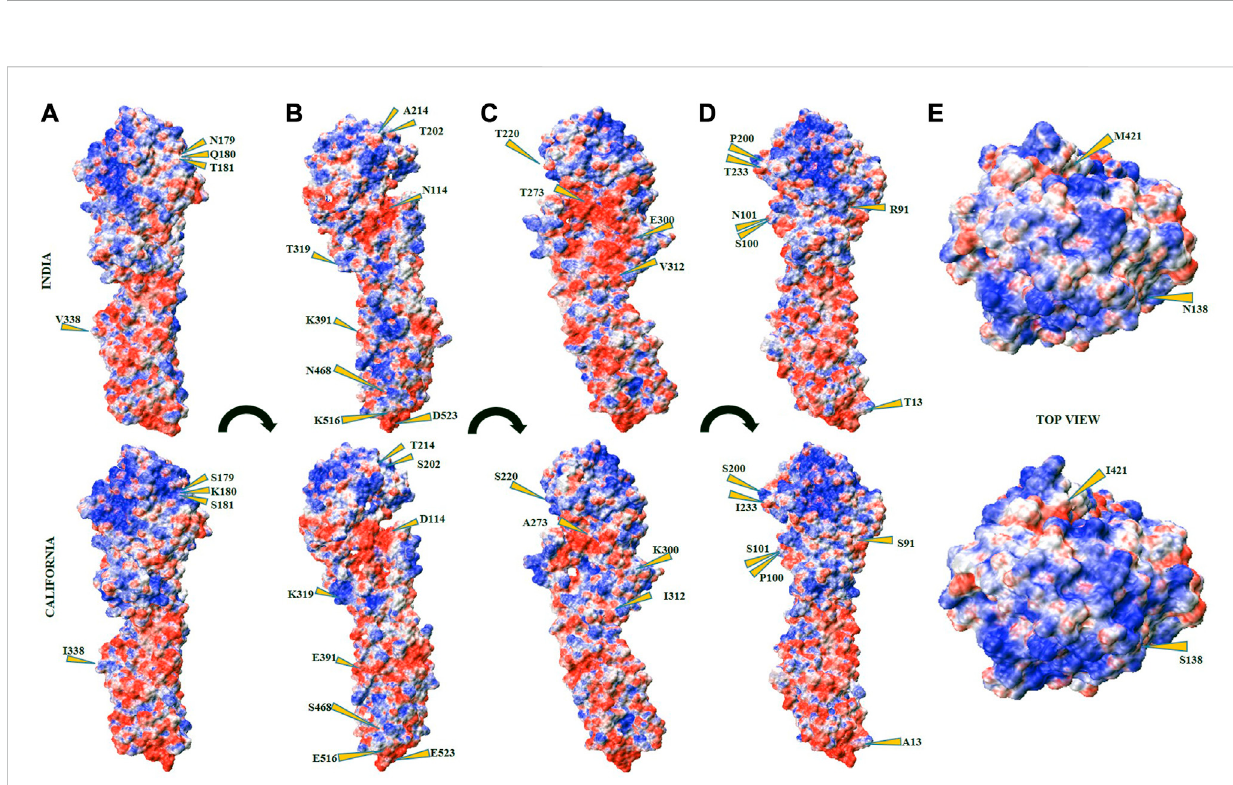
FIGURE 7 Electrostaticpotentialsurface(ESPS)ofHA Ind (toppanel)andHA Cal (bottompanel)proteins.Thesubsets (A – D) depictdifferentorientationsfromthe frontviewofHAproteinsurfacesintermsof90 ° withrespecttothelongaxispassingfromHA1toHA2domains. Thesubsets (E) depictthetopviewofHA from the HA1 domain. The positive, negative, and neutral ESPS are depicted in blue, red, and white surfaces,